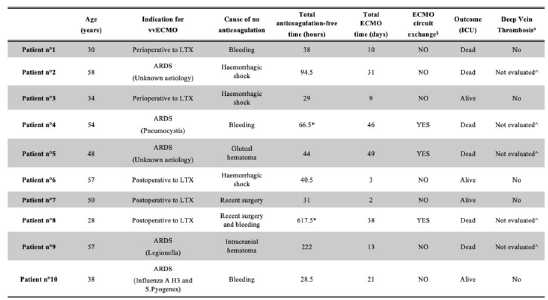
Table 1 (abstract 001130). LTX (lung transplant), ARDS (Acute Respiratory Distress Syndrome). *Two patients had more one anticoagulation-free vvECMO period (total anticoagulation-free time is considered). § ECMO circuit exchange during the anticoagulation- free period. °Evaluated through Compression Ultrasound (CUS) 24-48 hours after ECMO removal. ^Not evaluated because patient